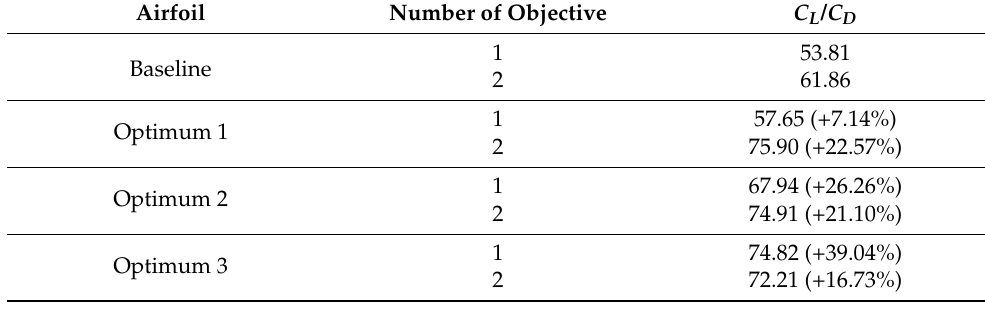
Figure 11. Comparison of shape between optimized airfoil and baseline. Table 3. Comparison of aerodynamic performance between baseline and optimized airfoils.